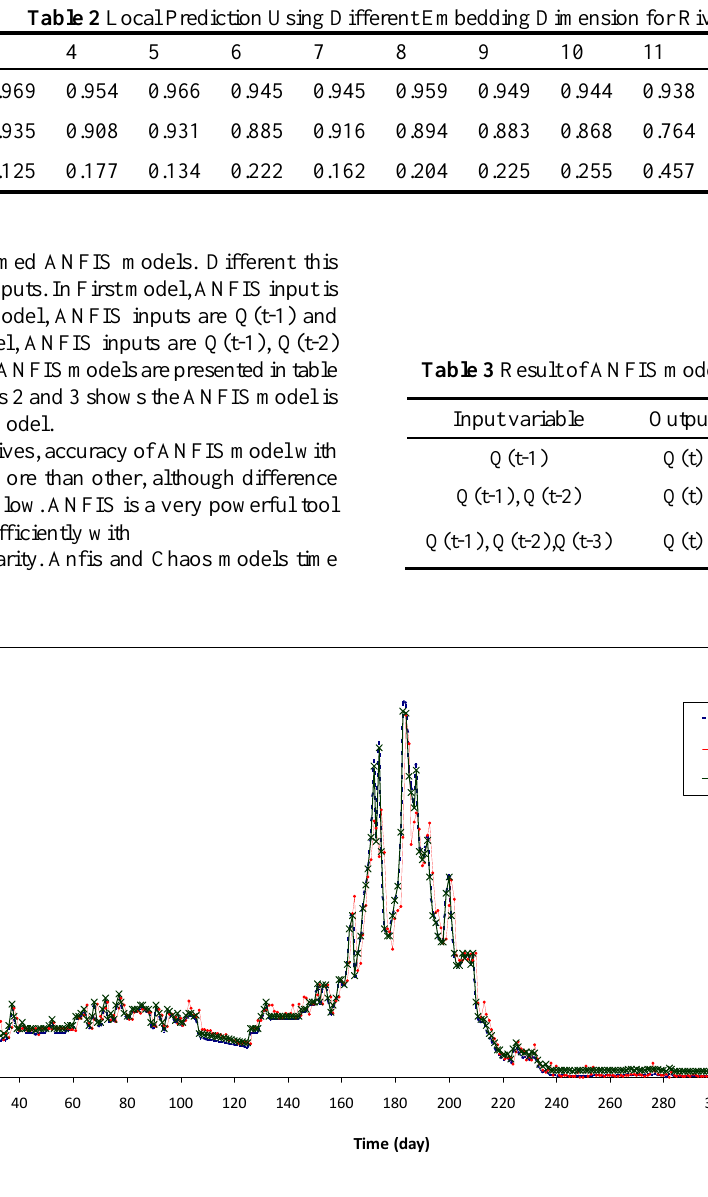
Fig.9 Comparison of ANFIS Prediction with the Local Prediction